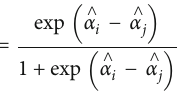
Table 1: Model ranking and ATP ranking of top 20 players on all surfaces. Model Players Estimates Rating rank